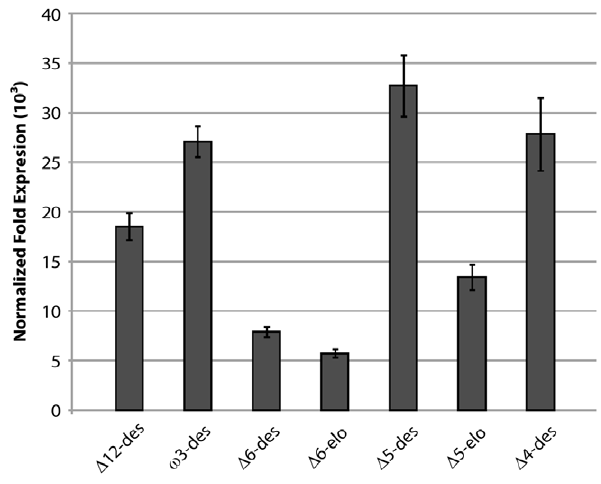
Figure 4. Real-Time quantitative PCR of transgenes in devel- oping DHA seed. Normal fold expression was calculated using the DD Ct method using a fatty acid biosynthesis gene, b -ketoacyl-acyl carrier protein synthase II (KASII), as the reference gene.